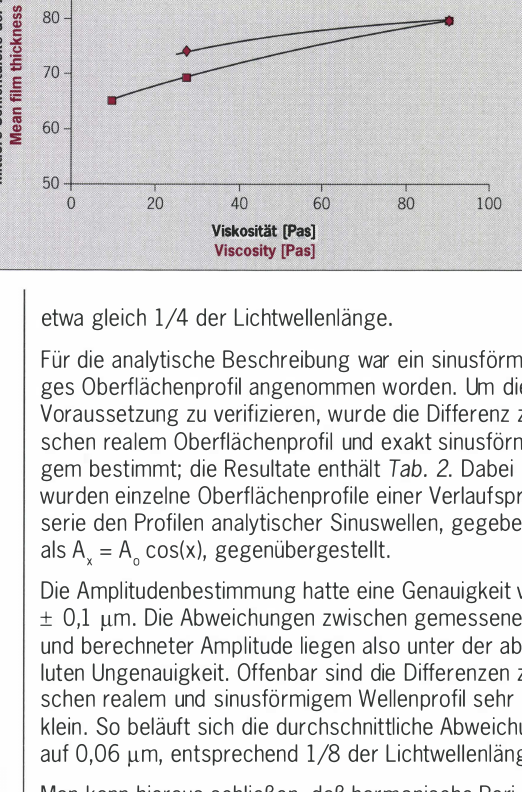
Fig. 6: Film thickness as a function of increasing viscos­ ity. All other parameters are kept constant